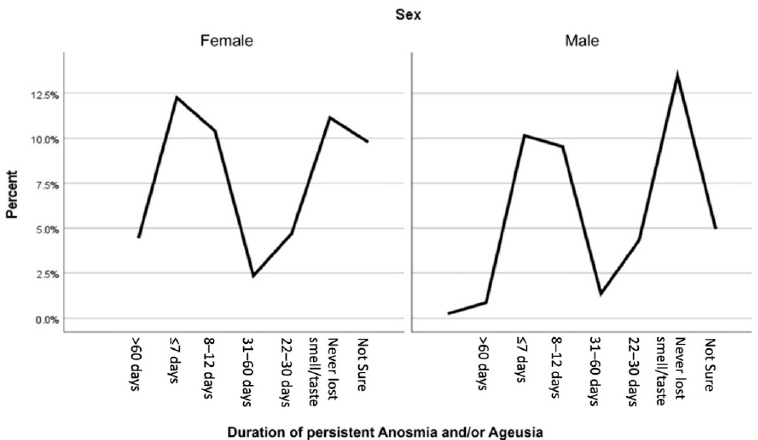
Figure 1. The association between sex and the duration of persistent anosmia and/or ageusia ( p = 0.001). A high incidence of anosmia during COVID-19 was found in younger patients, espe- Table 3. Demographic and clinical factors associated with experiencing anosmia. cially those in the third (44%) and fourth (22.2%) decades age group in comparison to older age groups ( p = 0.001). In addition, those patients in the third and fourth decades Presence of Anosmia were also associated to a lower extent with the occurrence of persistent anosmia by (43.2%) Variables during the and (41.9%), respectively ( p = 0.016) (Table 3). Regarding ageusia, age has a significant association with experiencing ageusia as one of the initial symptoms of COVID-19. Many of the participants who presented with ageusia as an initial symptom of COVID-19 infec- tion were from the third (42.6%) and fourth (23.3%) decades age group, establishing a